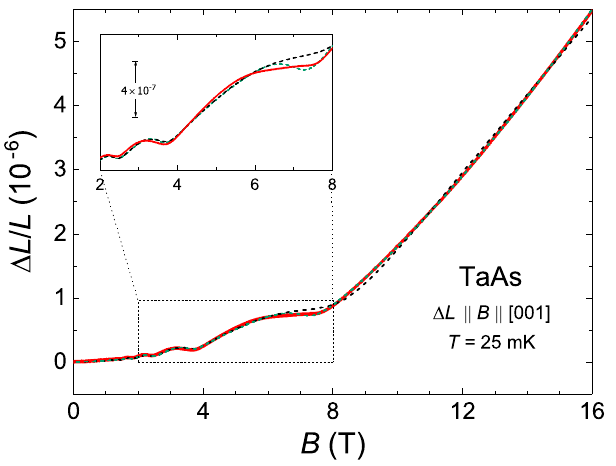
Fig. 3 Comparison of the calculated magnetostriction for the case of F W = 5 T with the experimental data for TaAs. The solid red line shows 2 the c -axis magnetostriction Δ L / L of TaAs measured at T = 25 mK and B ∥ c . The dashed green line depicts this magnetostriction calculated at T = 0 with formulas of Supplementary Notes 1 – 3 (assuming the constancy of the chemical potential ζ ) for the values of the parameters presented in Table 1 (set 1). The dashed black line shows the magnetostriction calculated in Supplementary Note 7 for T = 0 and for the same values of F i and γ i , taking into account the dependence ζ ( B ). The inset is a zoom into the last oscillations of the magnetostriction. Note the absence of a local minimum in the experimental curve above 6